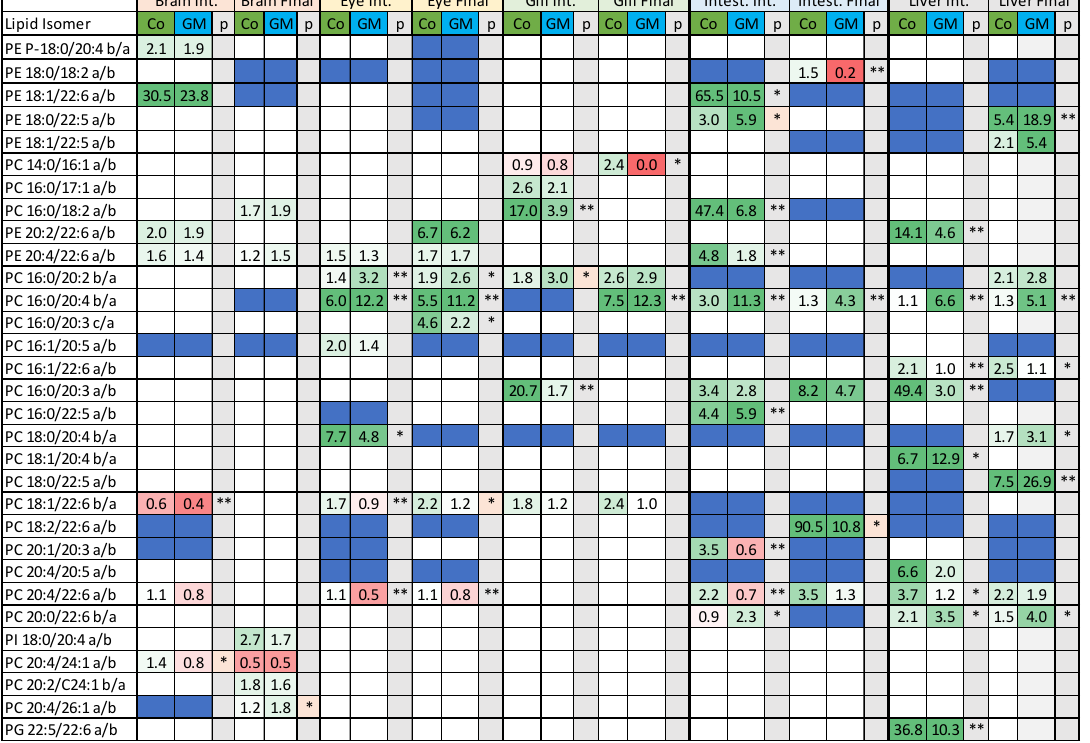
Figure 9. Potential sn isomers identified using the reverse phase LC-MS/MS methodology. Data are presented as the ratio of one isomer over the second isomer, with ratios determined using peak area data. Blue squares indicate that sn positional isomers were not detected, however fatty acyl isomers were detected. * p = 0.01–0.05, ** p < 0.01, red boxes indicate p values fell below the Benjamini-Hochberg critical